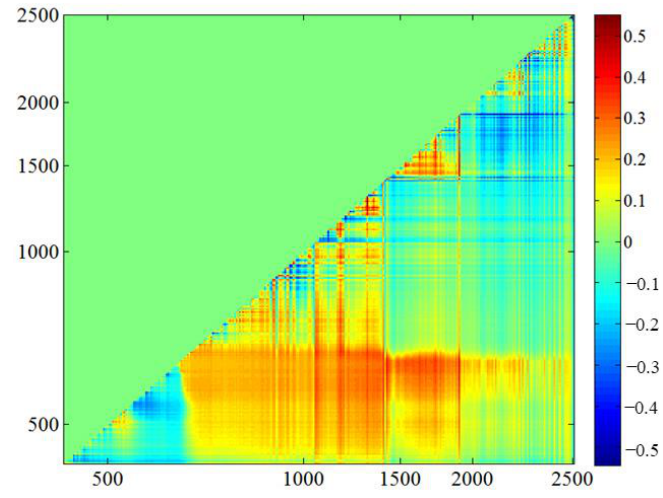
Figure 7. Correlation coefficient between SMC g and VIs.